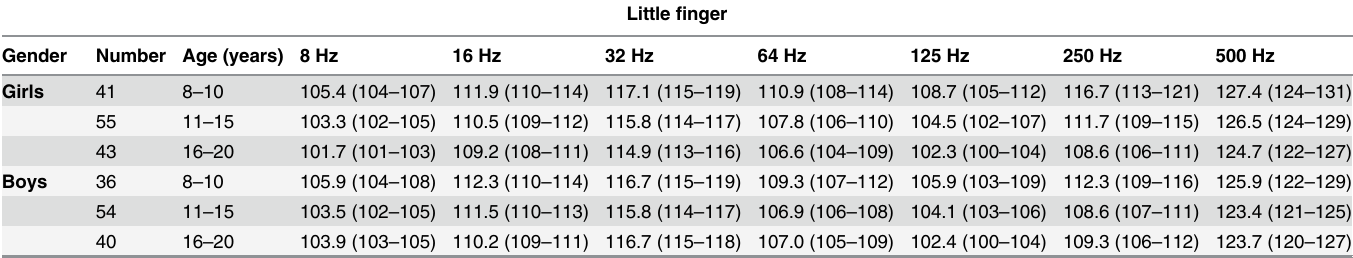
Values, expressed in dB (relative to 10 -6 m/s 2) , are means and 95% con fi dence intervals in